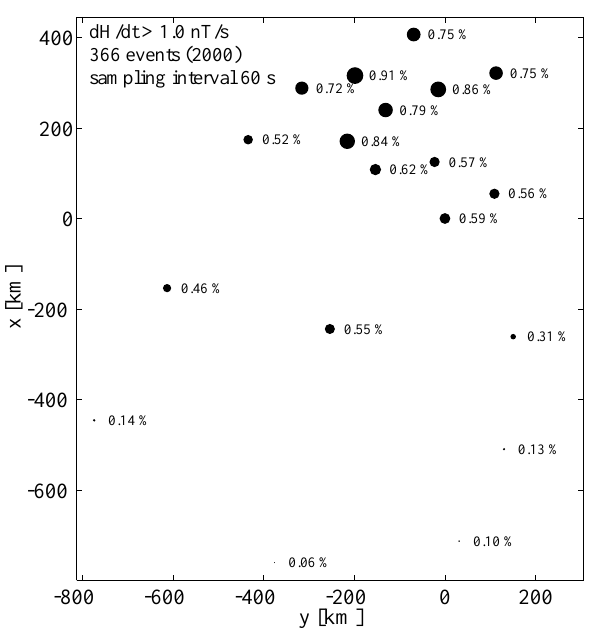
Fig. 7. Relative number of data points fulfilling the condition | d H /dt | > 1 nT/s at each station in Fig. 6. The radius of each circle is proportional to the percentage.